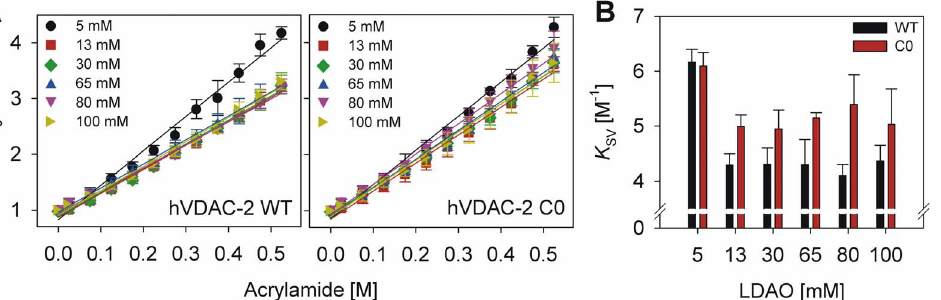
Figure 4. Probing surface accessibility of hVDAC-2 Trp residues using fluorescence quenching measurements. (A) Acrylamide quenching experiments of Trp fluorescence in refolded hVDAC-2 WT (left panel) and C0 (right panel) in different LDAO concentrations, fit to a linear function (fits are shown as solid lines). Protein refolded in 5 mM LDAO exhibits greater quenching with increasing acrylamide, which is a reflection of solvent-accessible Trp residues in this. Notably, the slopes of quenching measurements in C0 are consistently greater, even in higher LDAO, suggesting that the tryptophans remain acrylamide accessible in this protein. (B) K SV of hVDAC2 WT and C0 obtained from acrylamide quenching of Trp fluorescence at 25 u C, are compared in different LDAO concentrations. The error bars in all graphs indicate standard deviations from three independent experiments.